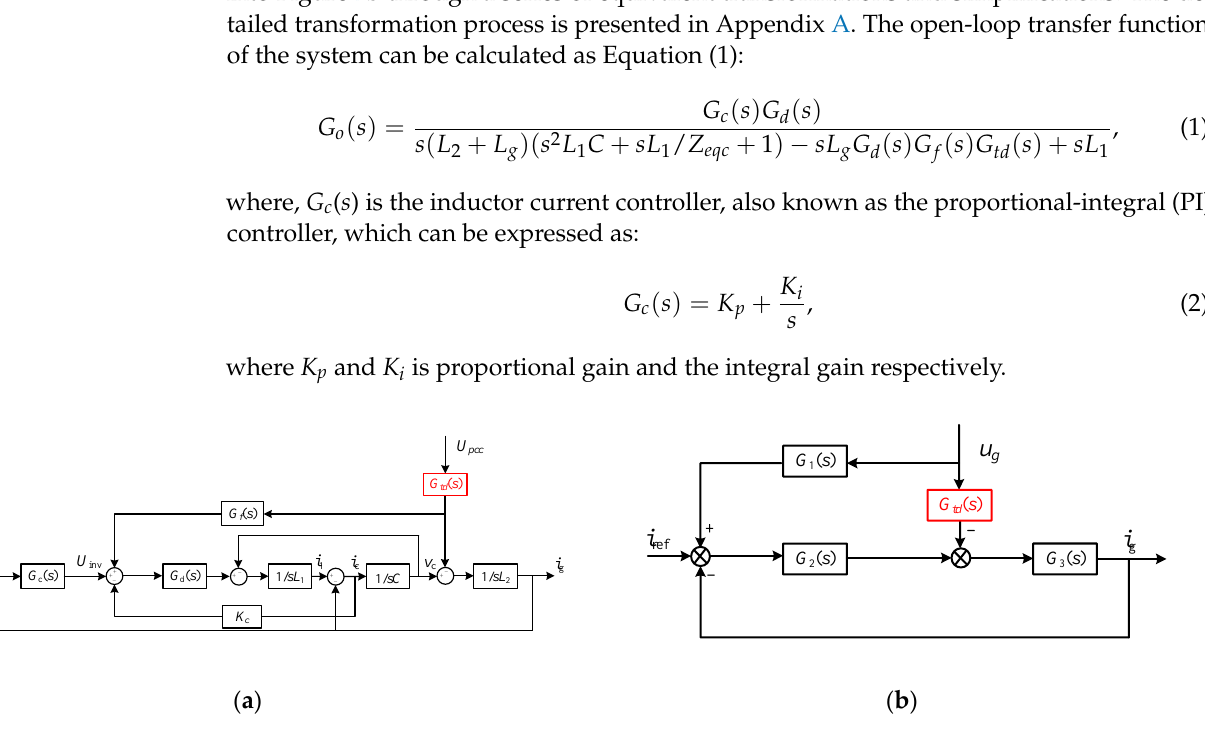
Figure 7. Block diagram of the LCL-typed grid-connected inverter. ( a ) Control block; ( b ) Simplified control